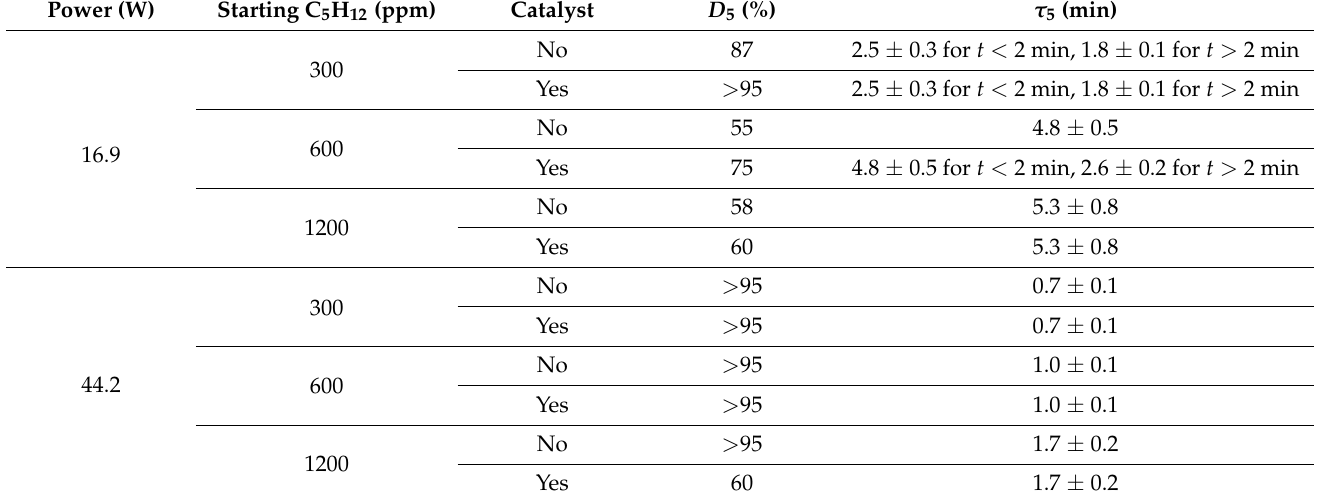
Table 1. Pentane decomposition for the plasma treatment time t =5 min, with and without a catalyst, for the two plasma powers and the three initial pentane concentrations considered in Figure5. The associated pentane decomposition times, τ 5 , are reported. The estimated errors for τ 5 are obtained by taking the highest and lowest slopes of the straight lines, consistent with the data shown in